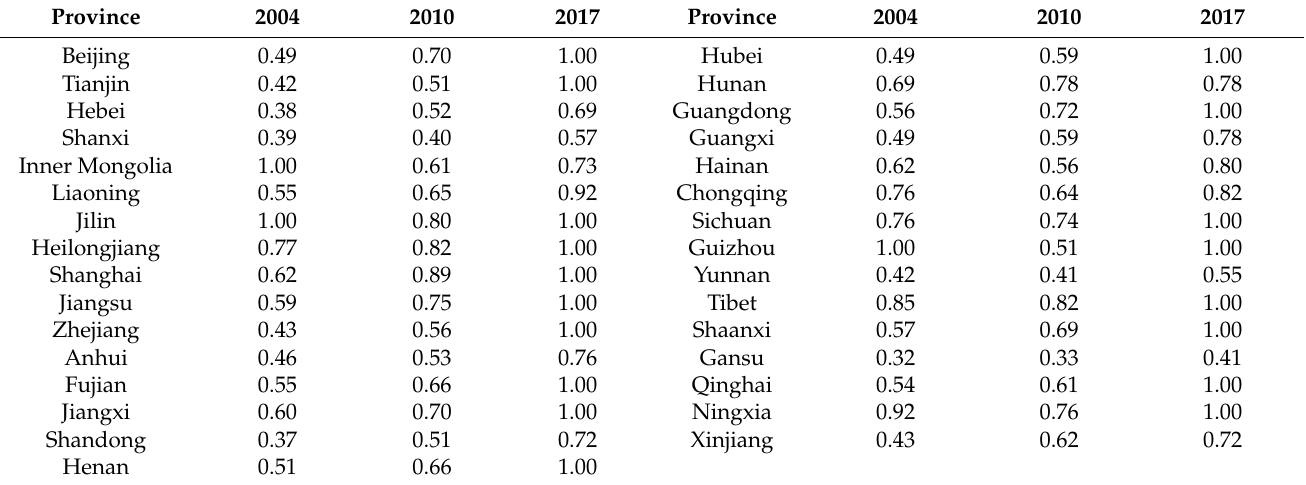
Table 4. The results of CLUE in major years.